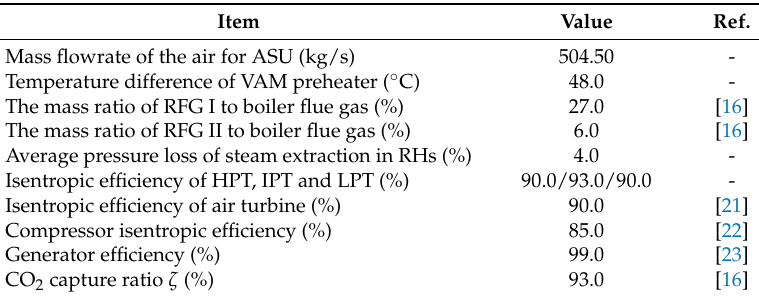
Table 3. Initial conditions and main